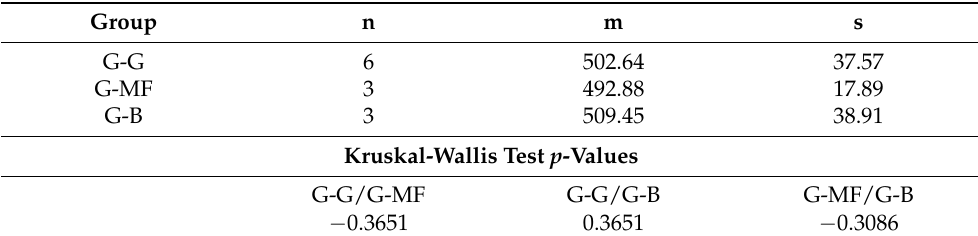
Table 7. Comparison of the mean (m) body mass with the standard deviation (s) in kg of the cohorts (n = number) of caballoid horses according to their diet using a Kruskal-Wallis statistical test. G-G: grazer according to meso- and microwear; G-MF: grazer according to mesowear analysis and mixed- feeder at the time of death (microwear analysis); G-B: grazer according to mesowear analysis and Browser at the time of death (microwear